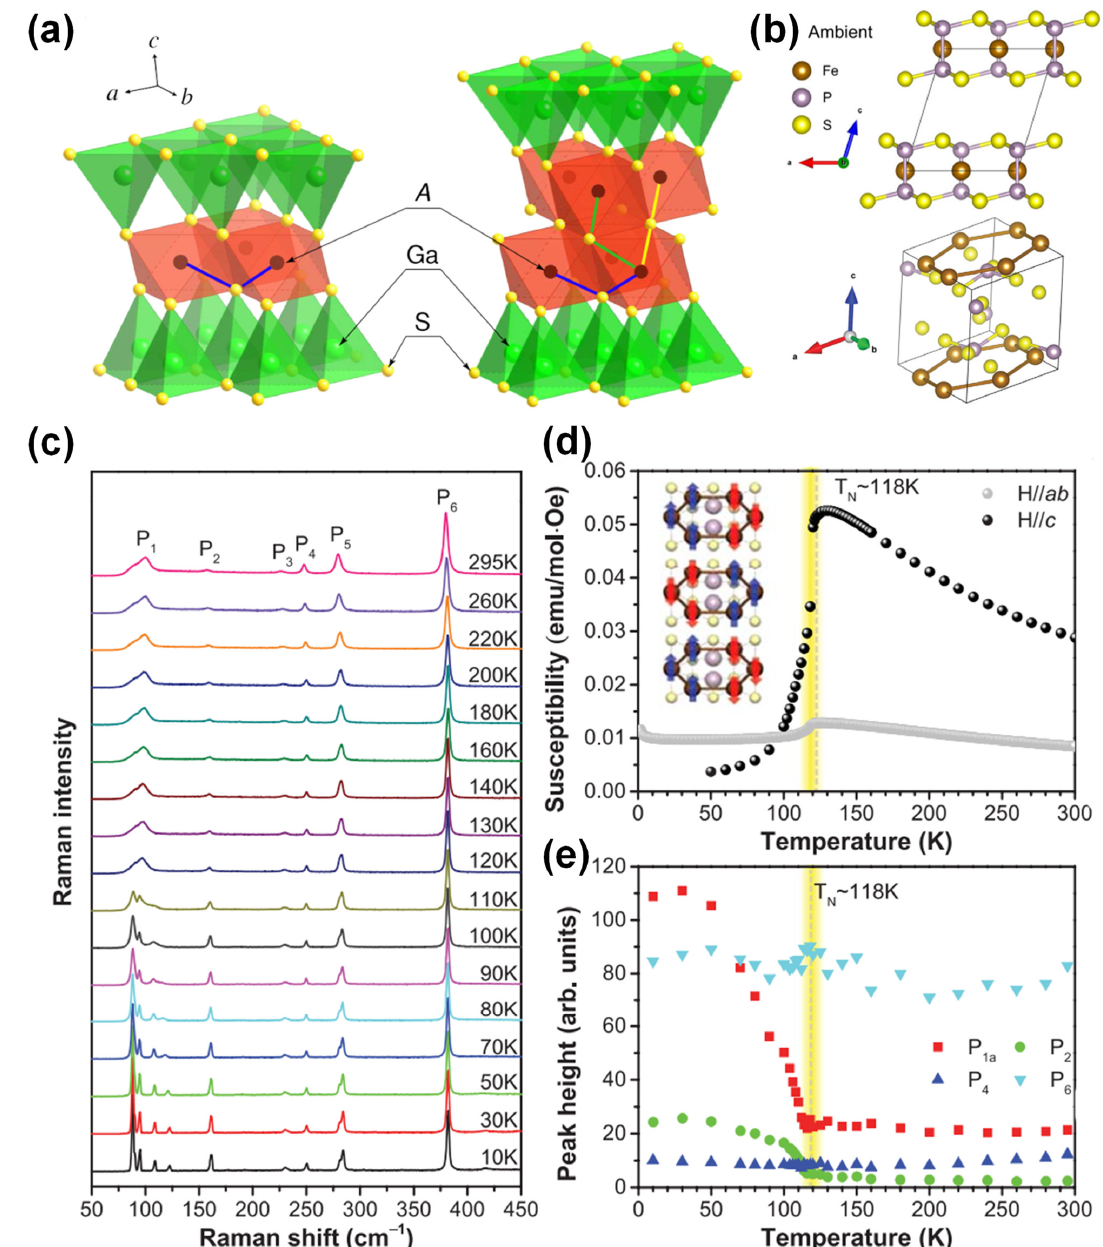
Figure 6. ( a ) Structure of the unit slab for single layered AGa 2 S 4 (A = Ni, Fe) (Left) and bilayer Fe 2 Ga 2 S 5 (Right). Superexchange paths are shown by lines within the diagrams (color online). Reused with permission from [160]. ( b ) Crystal structure of ambient-pressure FePS 3 . Reused with permission from [168]. ( c ) Temperature dependence of Raman spectrum for bulk FePS 3 . Reused with permission from [161]. ( d ) Temperature dependence of magnetic susceptibility for bulk FePS 3 along with the a- and b- (black spheres) and c- (gray spheres) axes. Reused with permission from [161]. ( e ) Temperature dependence of the intensities of several Raman peaks for bulk FePS 3 . Reused with permission from [161] .